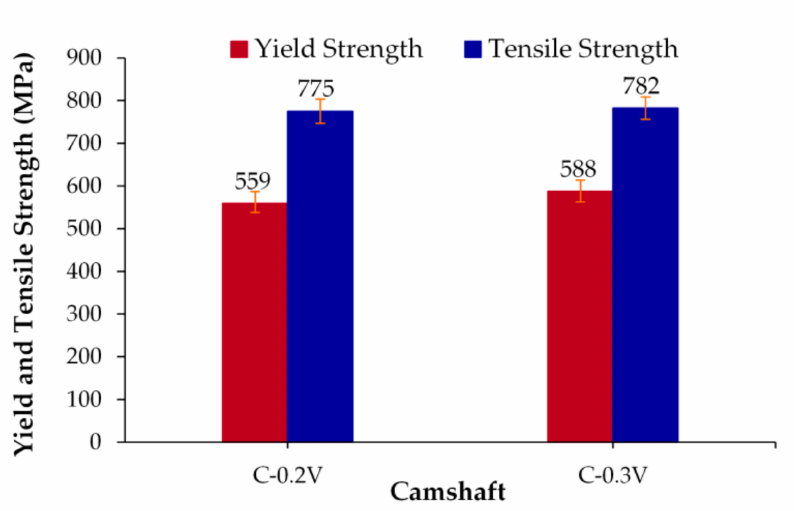
Figure 6. Influence of vanadium content on yield and tensile strength.